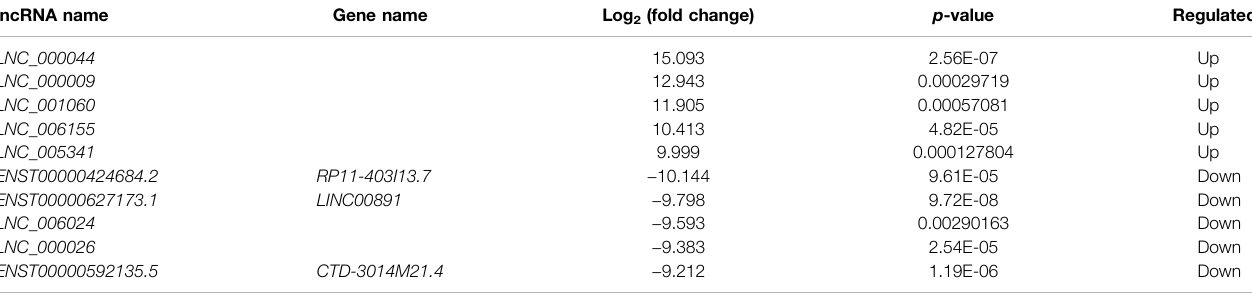
TABLE 6 | Top 10 differentially expressed lncRNAs.